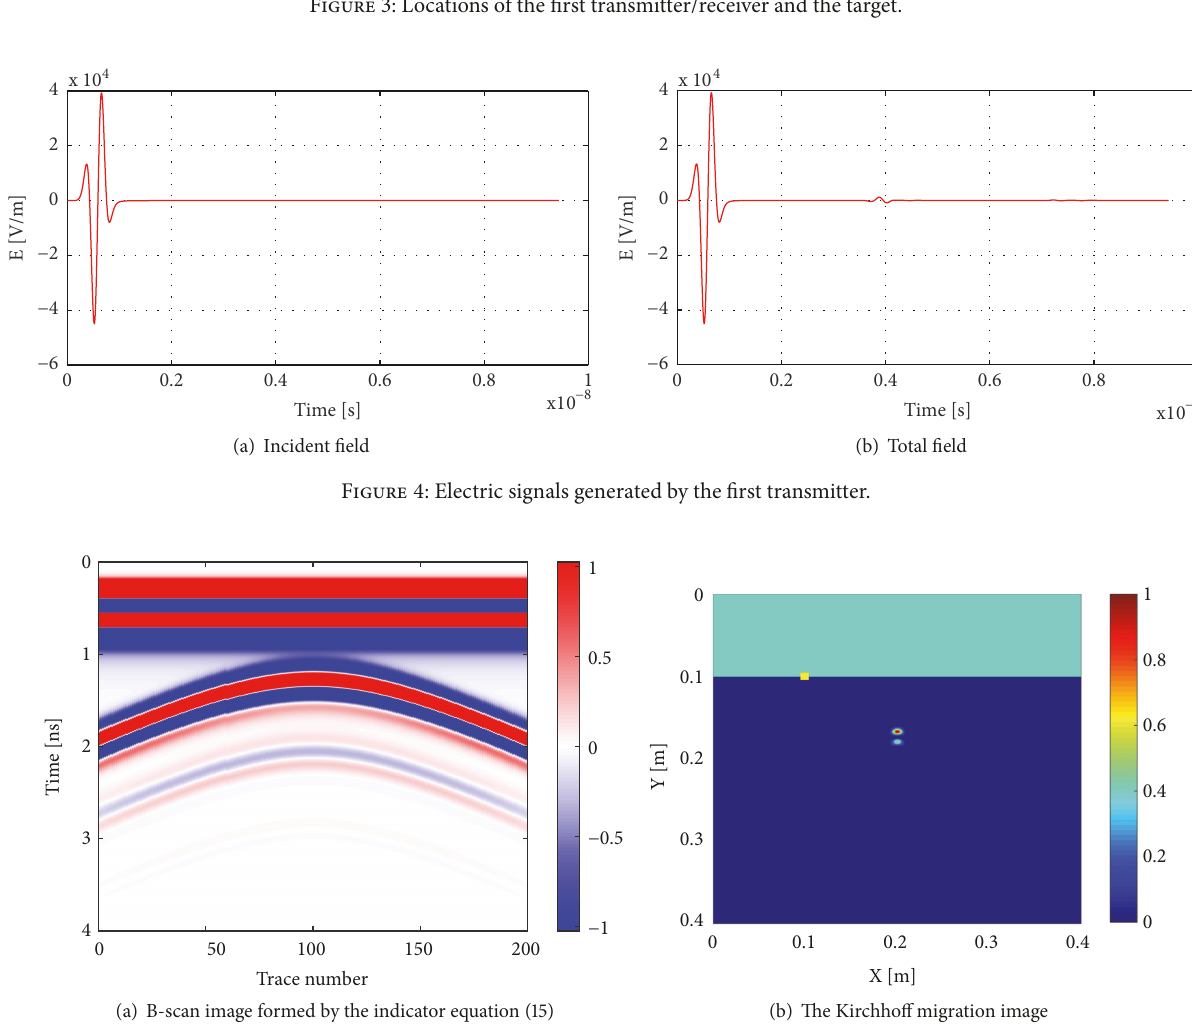
Figure 5: Imaging a small scatterer using synthetic data without